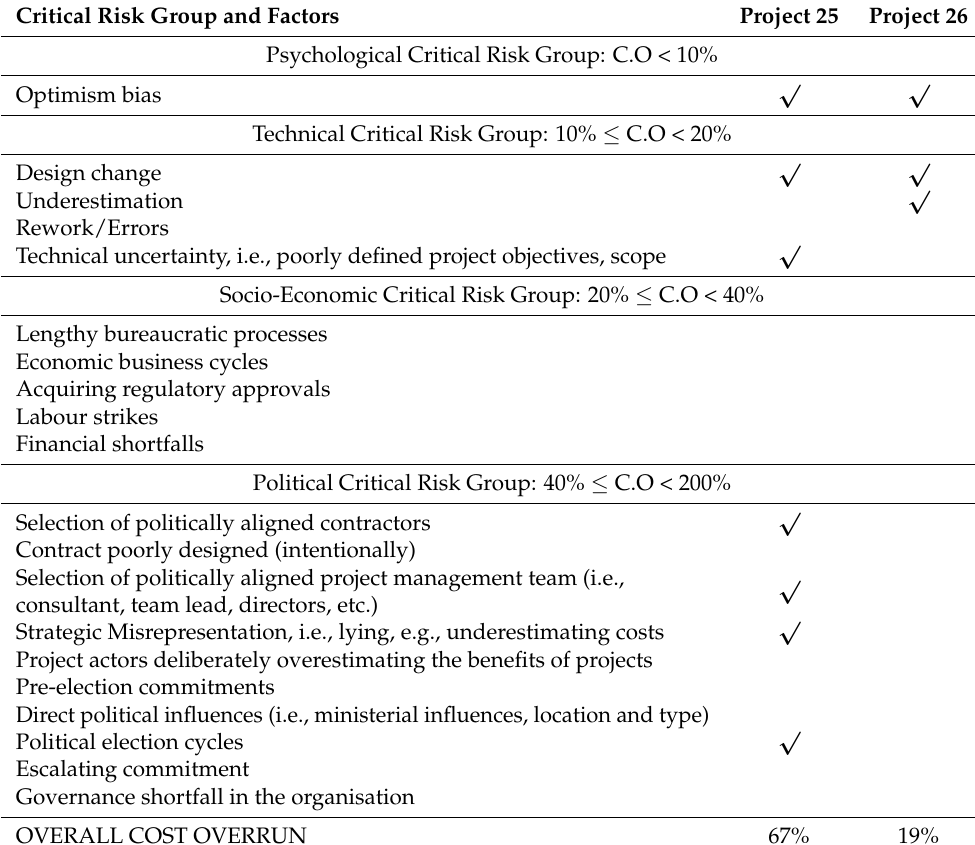
Table 5. Test for levels of CO percentages [7]: Perceived presence of critical risk